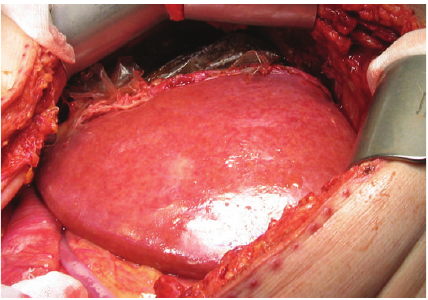
Figure 2: The liver in a patient with large HCC on the right side at the beginning of stage 2 operation; a plastic bag is placed around the right liver half and segment